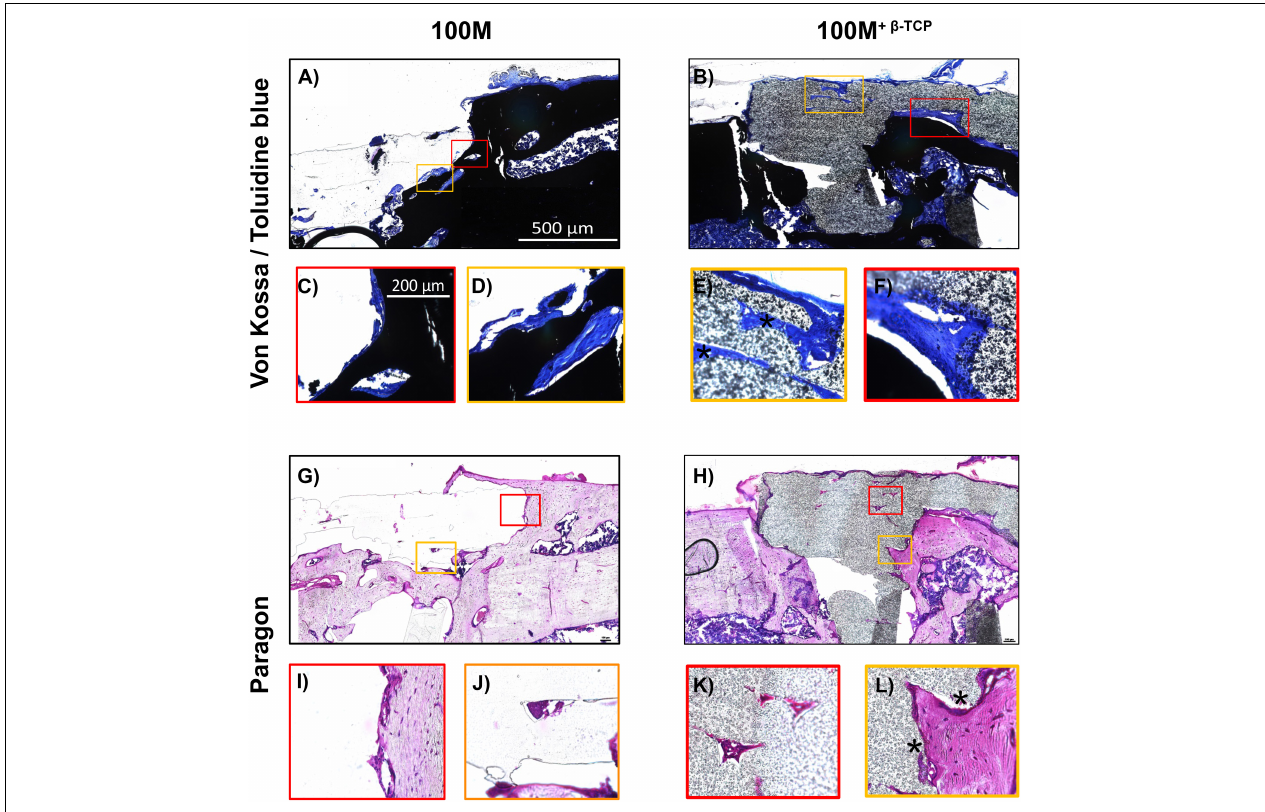
FIGURE 10 | High magnification evaluation of implanted scaffolds. High magnification images of Von Kossa/Toluidine blue (A–F) and paragon staining (G–L) confirmed an increase in osteoid content in the 100M + β - TCP implanted scaffolds in the interface between mineralized tissue and scaffold. Osteoid and structures resembling vascular channels were even found inside of the 100M + β - TCP implant (E,L) , as well as a periosteal-like structure covering it (asterisk). Taken together, these findings strongly suggest that the 100M + β - TCP implant is invaded by cells that are able to proliferate inside of its filaments, thereby promoting an adequate environment to foster tissue regeneration. The granular appearance of the scaffold is due to its β -TCP content. In contrast, limited tissue ingrowth and neither a periosteal-like membrane or blood vessels were found in 100M scaffolds. Images were obtained at 10 × (A,B,G,H) or 40 × magnification (C–F,I–L) and are representative of N = 8 100M and N = 16 100M + β - TCP scaffolds at 6 weeks